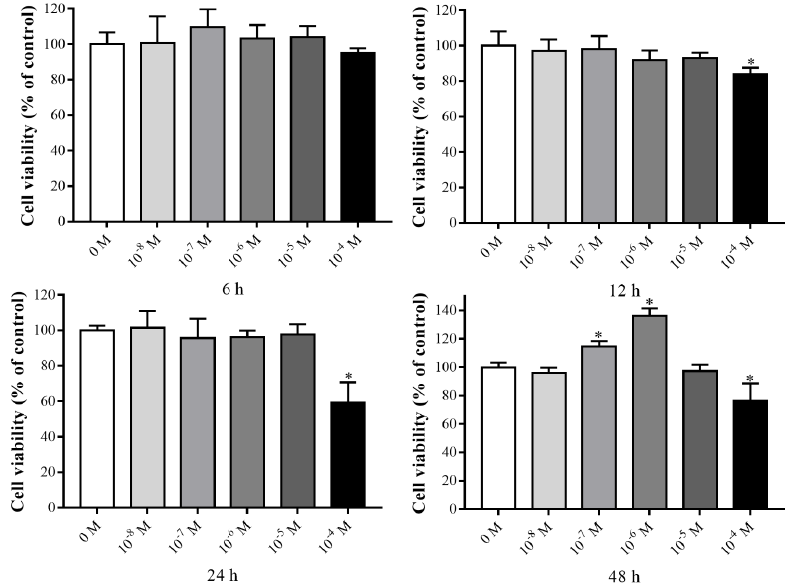
Figure 1. Cell viability effect of VK 2 on C3H10 T1/2 clone 8 cells. The data are presented as the mean ± SEM; * denotes a significant difference with respect to the control group ( p < 0.05).